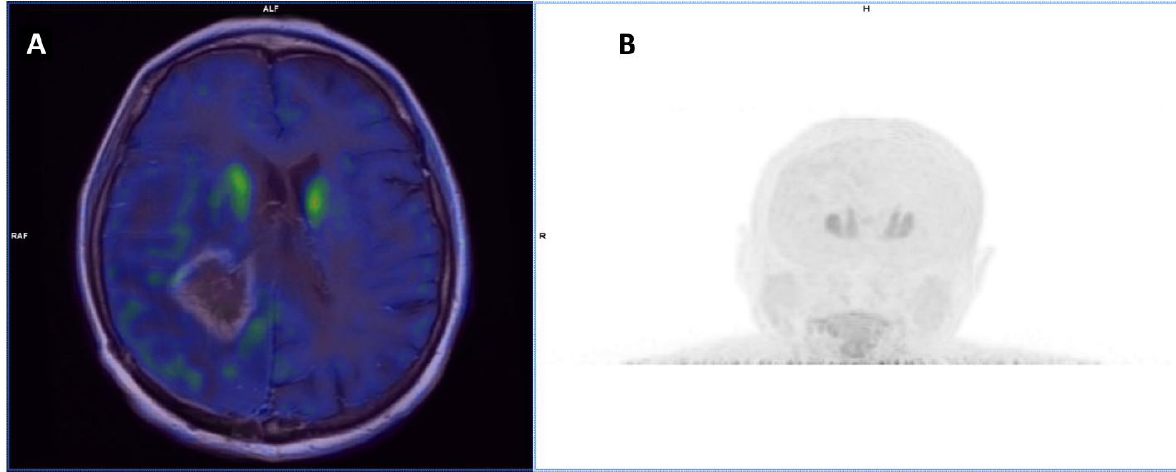
Figure 3. ( A ). [ 18 F]-DOPA PET transaxial images fused with diagnostic brain T1 FSE ceMRI in a patient with multiple BM from breast cancer. The patient was previously treated with WBRT followed by surgical excision of the largest BM (right parietal lobe) and stereotactic RT on the surgical bed. Post-RT ceMRI showed a significant size increase in the right periventricular area with ring-enhancement in differential diagnosis between radionecrosis and disease progression. PET showed the absence of correspondent [ 18 F]-DOPA uptake, compatible with pseudoprogression. ( B ). [ 18 F]-DOPA maximum intensity projection image, showing encephalic physiological distribution of [ 18 F]-DOPA; note the symmetric intense striatal